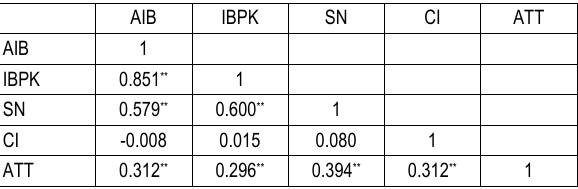
Table 4. Correlations between constructs